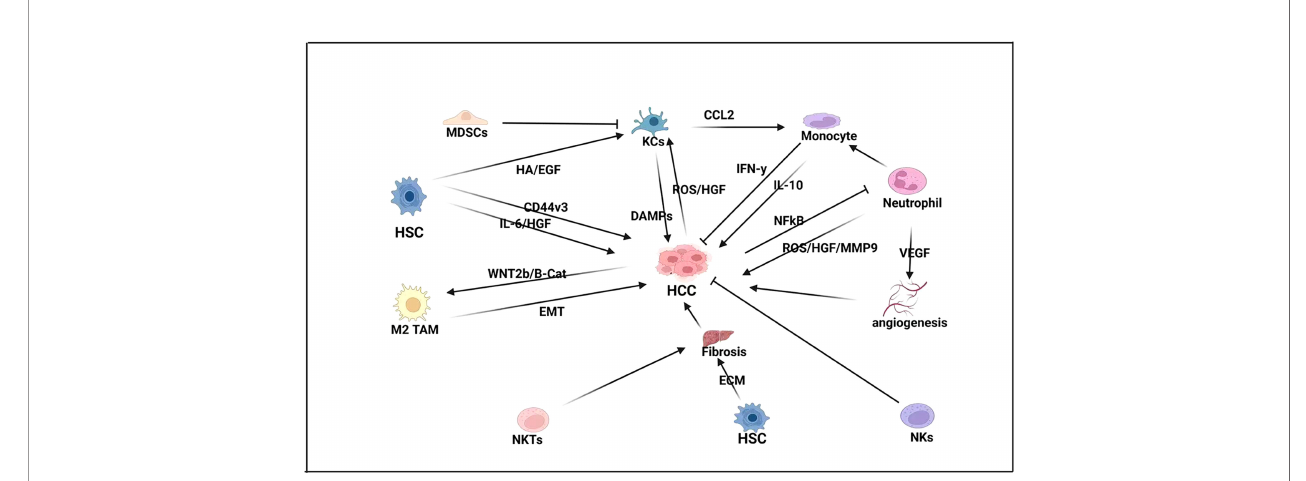
FIGURE 1 | Innate immune response in HCC-BM. In HCC pathogenesis, hepatic stellate cells (HSCs) drive fi brogenesis by promoting extracellular matrix (ECM), as well as directly in fl uencing proliferation by expressing pro-in fl ammatory cytokines like interleukin-6 (IL-6) and hepatocyte growth factor (HGF). HSCs also express the glycoprotein CD44v3 that promotes cell migration and invasion in HCC. Natural killer T (NKT) cells also promote fi brogenesis while neutrophils express vascular endothelial growth factor (VEGF) to promote angiogenesis and proliferation. Neutrophils also activate monocytes that can both repress HCC by expressing interferon-gamma (IFN- g ) and promote HCC by expressing interleukin-10 (IL-10). Kupffer cells (KCs) also play a crucial role in HCC pathogenesis by promoting monocytes by expressing C-C motive chemokine ligand-2 (CCL2), which acts as a monocyte attracting protein. KCs also express damage-associated molecular pattern molecules (DAMPs) and are activated by HSC. Expression of histamine (HA) and epidermal growth factor (EGF), as well as HCC expression of reactive oxygen species (ROS) and hepatocyte growth factor (HGF). However, KC expression is modulated by myeloid-derived suppressor cells